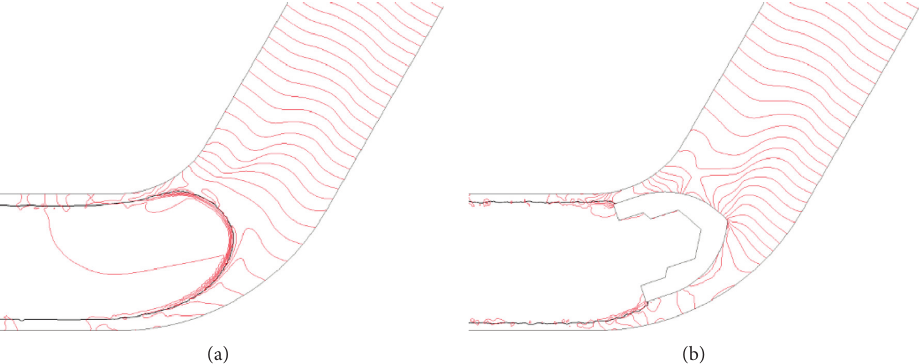
Figure 10: Comparison of the pressure contours near the penetration front at the middle location of curved segments between WAIM and W-PAIM: (a) WAIM and (b)